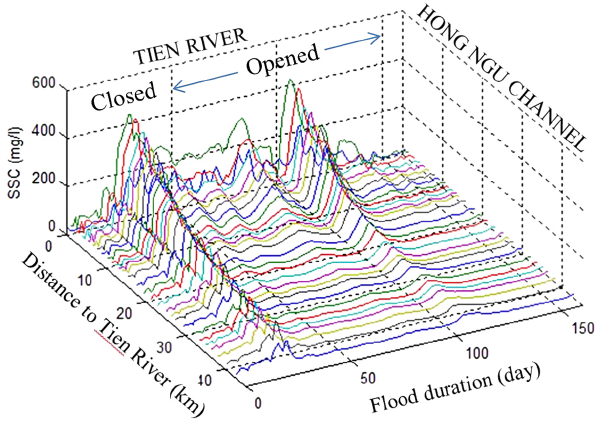
Figure 9. Typical SSC reduction in the channels with distance to the main river in the Plain of Reeds, exemplarily shown for the Hong Ngu channel in